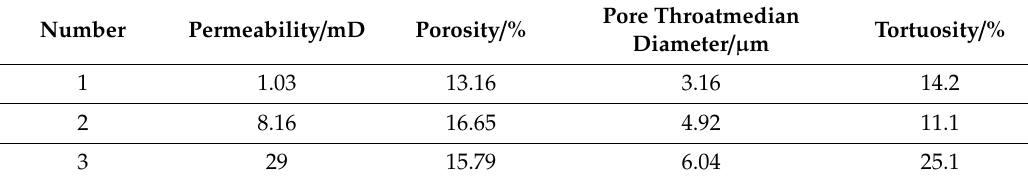
Table 2. Pore throat data of three outcrop